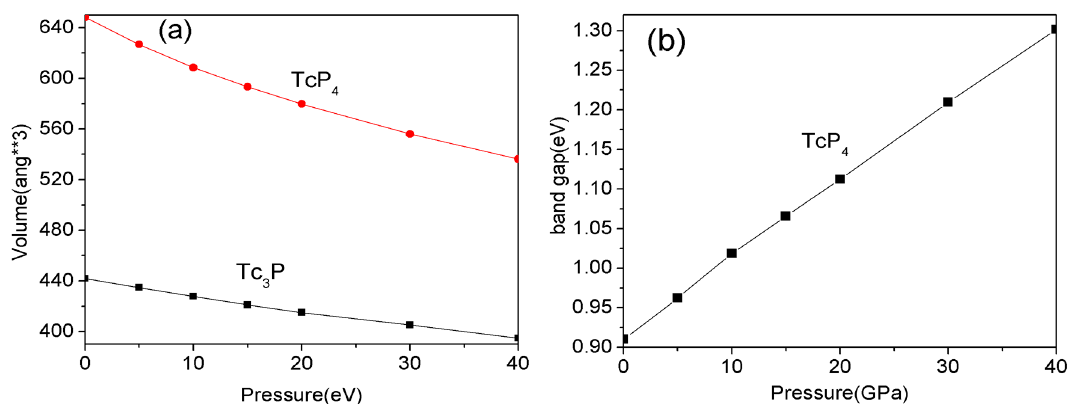
Figure 3. ( a ) The dependence of the cell volume on pressure for the Tc 3 P and TcP 4 crystal; ( b ) The dependence of the band gap on pressure for the TcP 4 crystal.